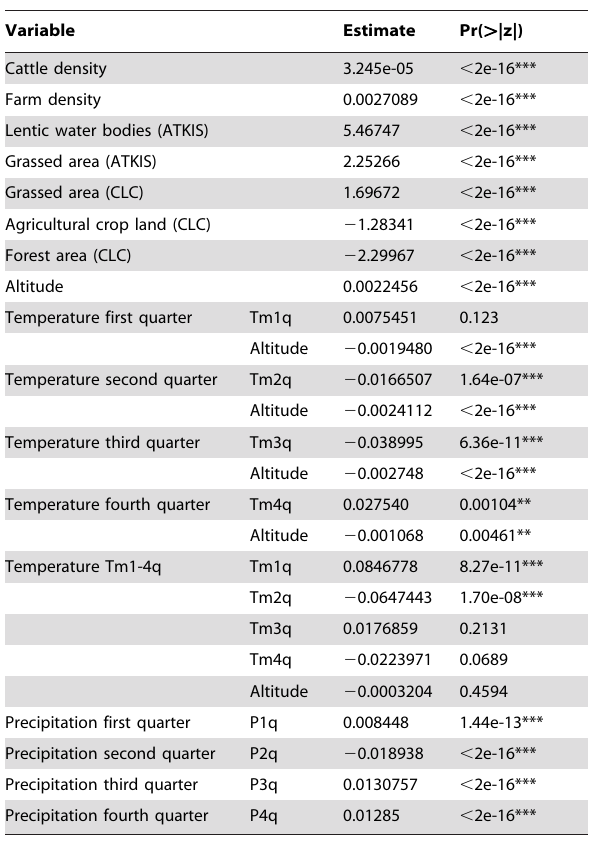
Table 2. Bivariate statistical analysis. Table 3. Multivariate statistical analysis, full logistic regression